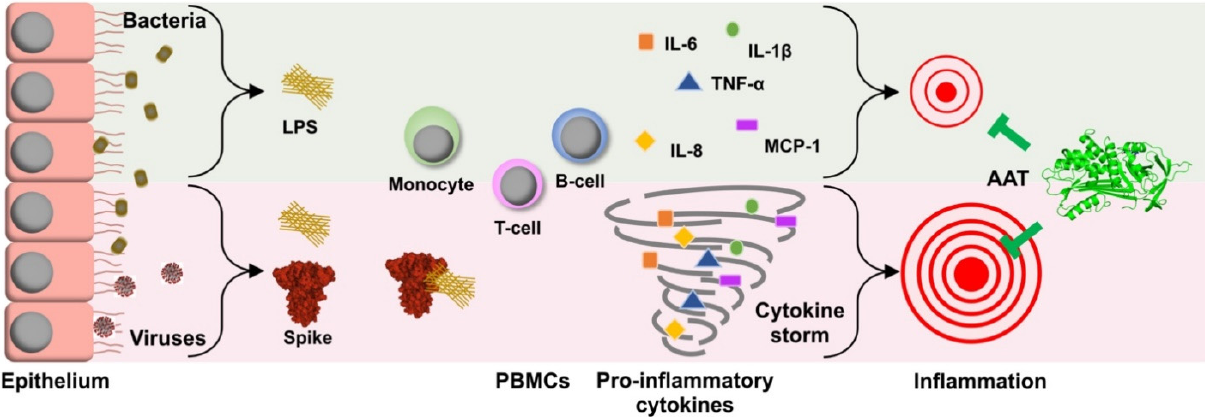
Figure 3. Schematic representation of putative suppression of the cytokine storm induced in the presence of SARS-CoV2 spike protein by alpha 1-antitrypsin (AAT): co-incubations of trimeric spike (S) protein along with bacterial LPS induced the pro-inflammatory cytokines production to several folds higher than in the presence of LPS alone. AAT is well-appreciated for its contribution in modulating the immune responses by suppressing pro-inflammatory cytokine and chemokine production. In addition, emerging evidence strongly suggests a role of AAT in the suppression of SARS-CoV2 infection. Our findings support a notion that AAT could dampen the cytokine storm caused by LPS-spike co-action.